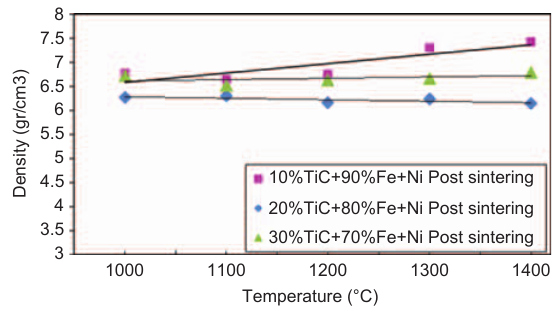
Figure 1 Density-temperature changes in Ni plated